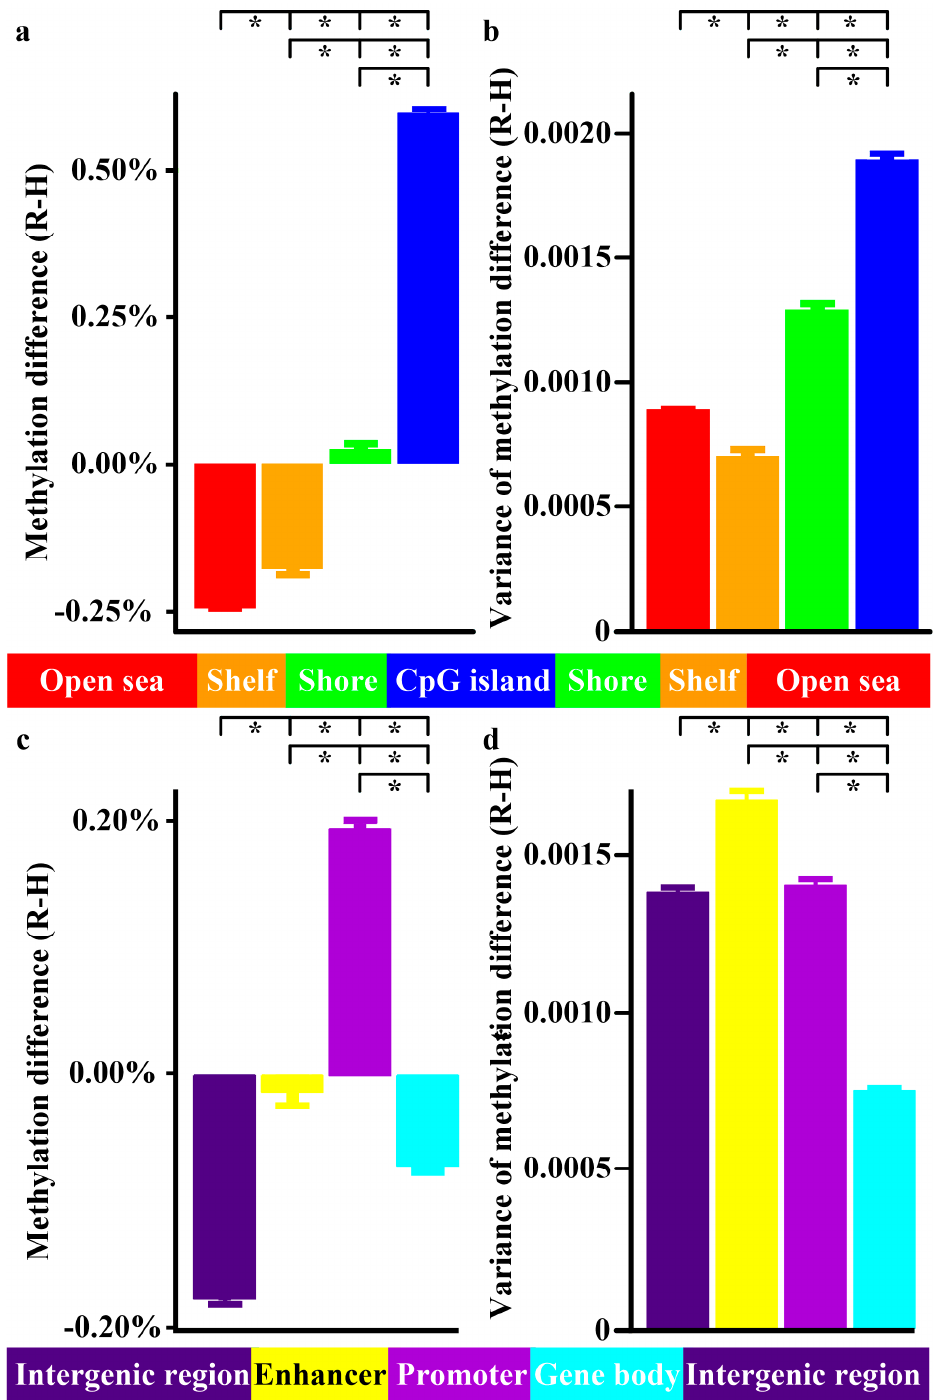
Figure 2. Methylation differences according to CpG features and genic characteristics. The bar charts showed the methylation difference (rheumatoid arthritis (R) minus healthy donor (H)) in CpG island, CpG shore, CpG shelf, open sea ( a ) and variance of methylation according to respective CpG features ( b ). Methylation difference in intergenic region, enhancer, promoter, gene body ( c ) and variance of methylation in respective genic characteristics ( d ) were also presented. * p < 0.001 for methylation difference and variance of methylation between different CpG features and genic characteristics.